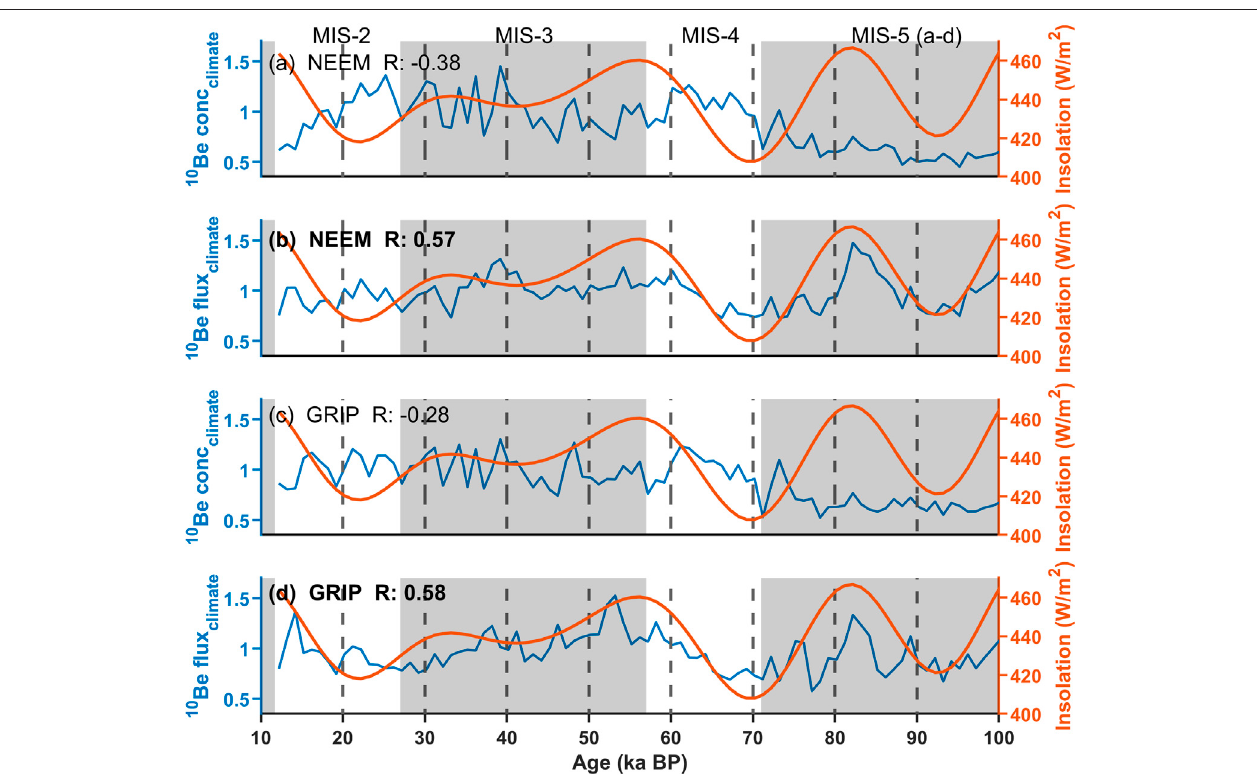
FIGURE 2 | Comparison of the geomagnetic corrected 10 Be records ( 10 Be conc climate and 10 Be fl ux climate ) of NEEM and GRIP ice cores and summer insolation at 65 ° Noverthelastglacialperiod.TheR-valueisthePearsoncorrelationbetween 10 Beandinsolation.TheRinboldindicatesthesigni fi cantvalue( p < 0.01,student t-test adjusted by the autocorrelation following (Hu et al.,